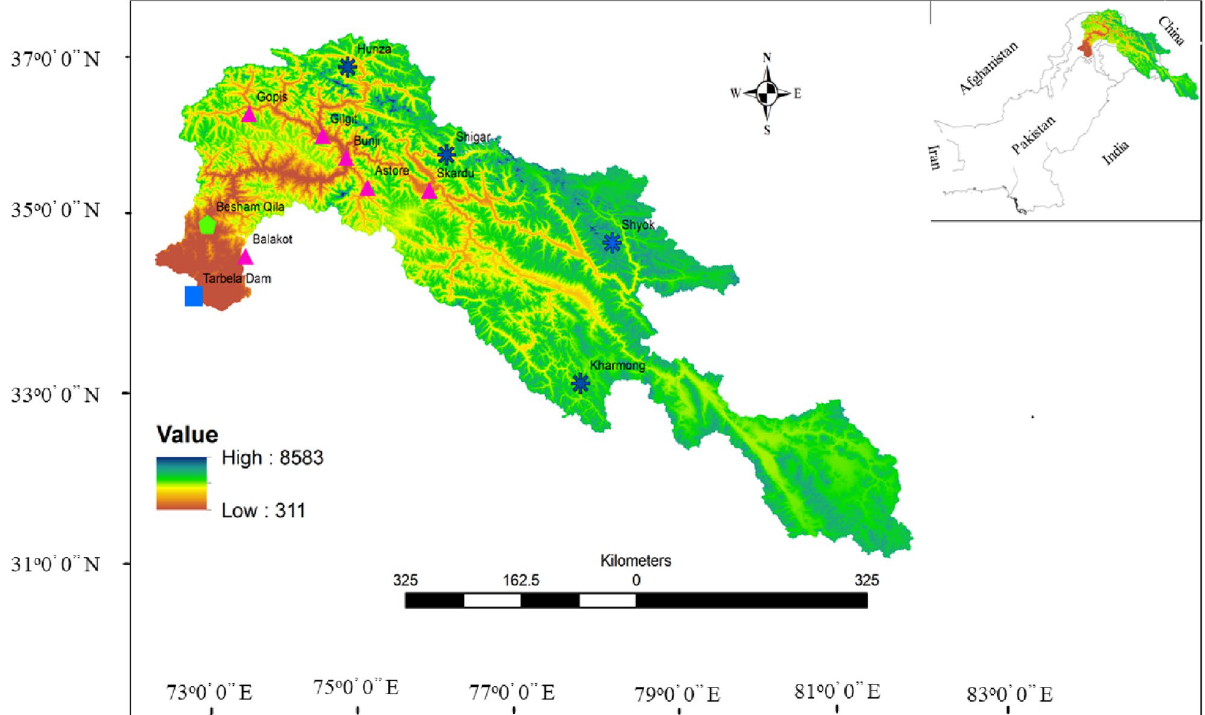
Figure 1. This figure show Pakistan and the Upper Indus Basin. The enlarged part shows the Upper Indus Basin where the meteorological stations are represented by pink tringles, subbasins by dark blue asterisk, Besham Qila by green pentagon and Tarbela Reservoir by blue square. This figure is created by using in ArcGIS version 10.6.1.